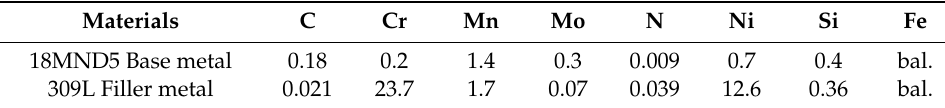
Table 1. Chemical composition of the materials (in wt. %).